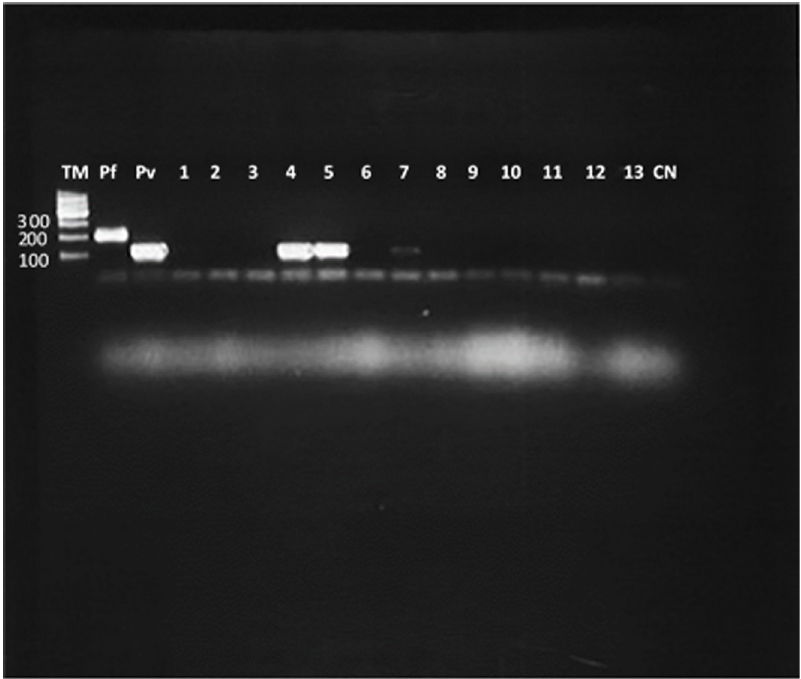
Fig 6. Nested PCR agarose gel electrophoresis to detect infection by Plasmodium spp . in pool of Anopheles spp . TM: DNA ladder (100bp, Qiagen), Pf: P . falciparum positive control (205 bp), Pv: P . vivax positive control (120 pb), Lane 1,3,6,8,9: pool samples of An . (Nys . ) albimanus negative, lane 2,10,11,12,13: pool sample of An . (Nys . ) darlingi negative, lane 4 and 5: pool sample An . (Nys . ) darlingi positive for P . vivax , lane 7: pool sample An . (Nys . ) albimanus positive for P . vivax , CN: negative control of